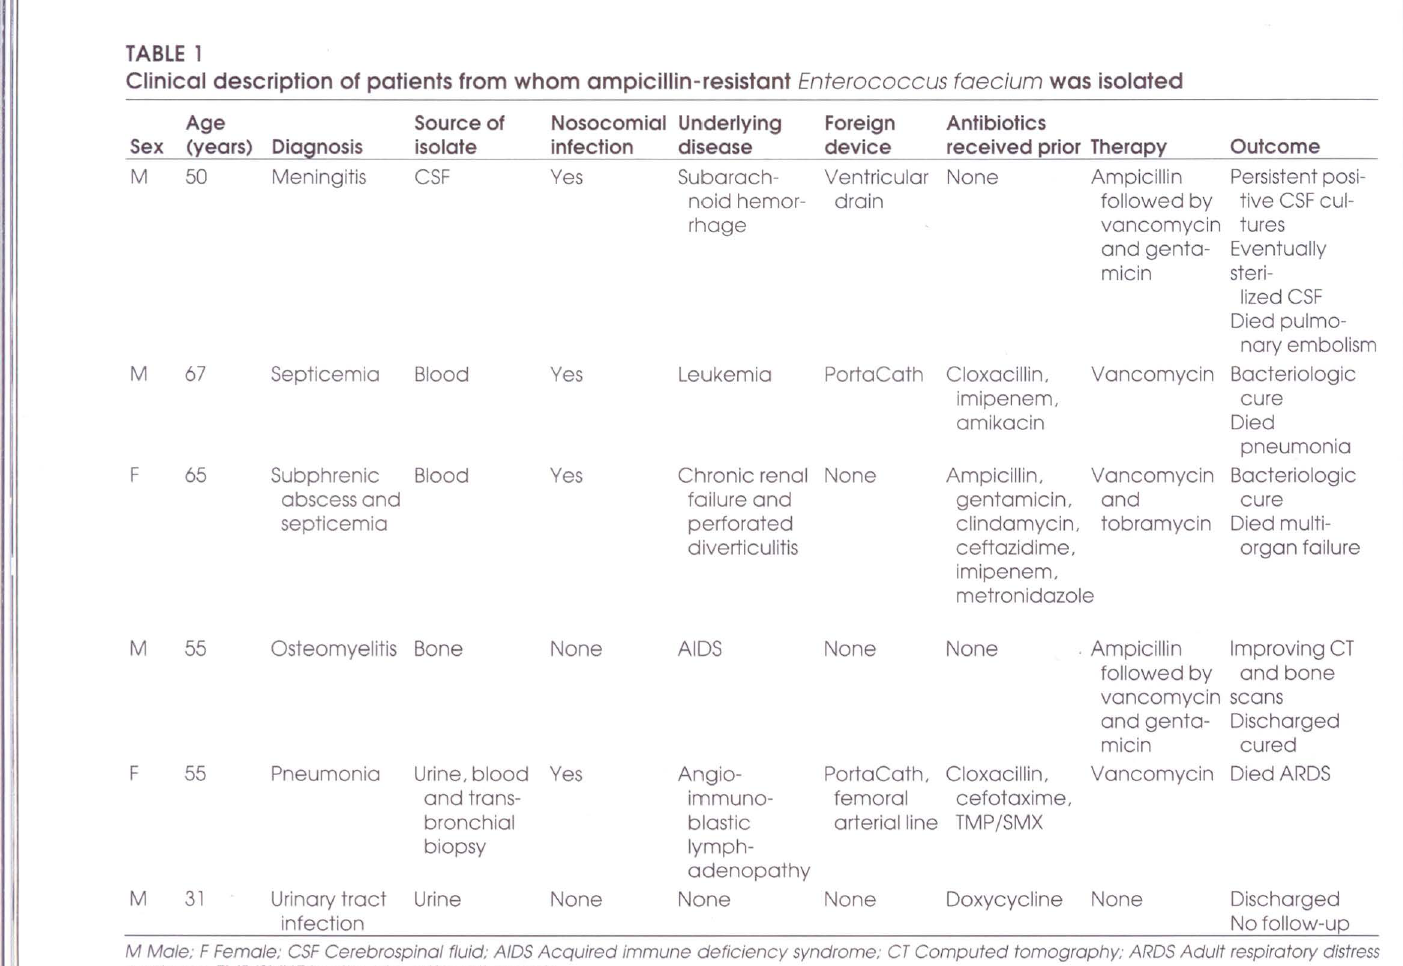
Clinical description of patients from whom ampicillin-resistant Enterococcus faecium was